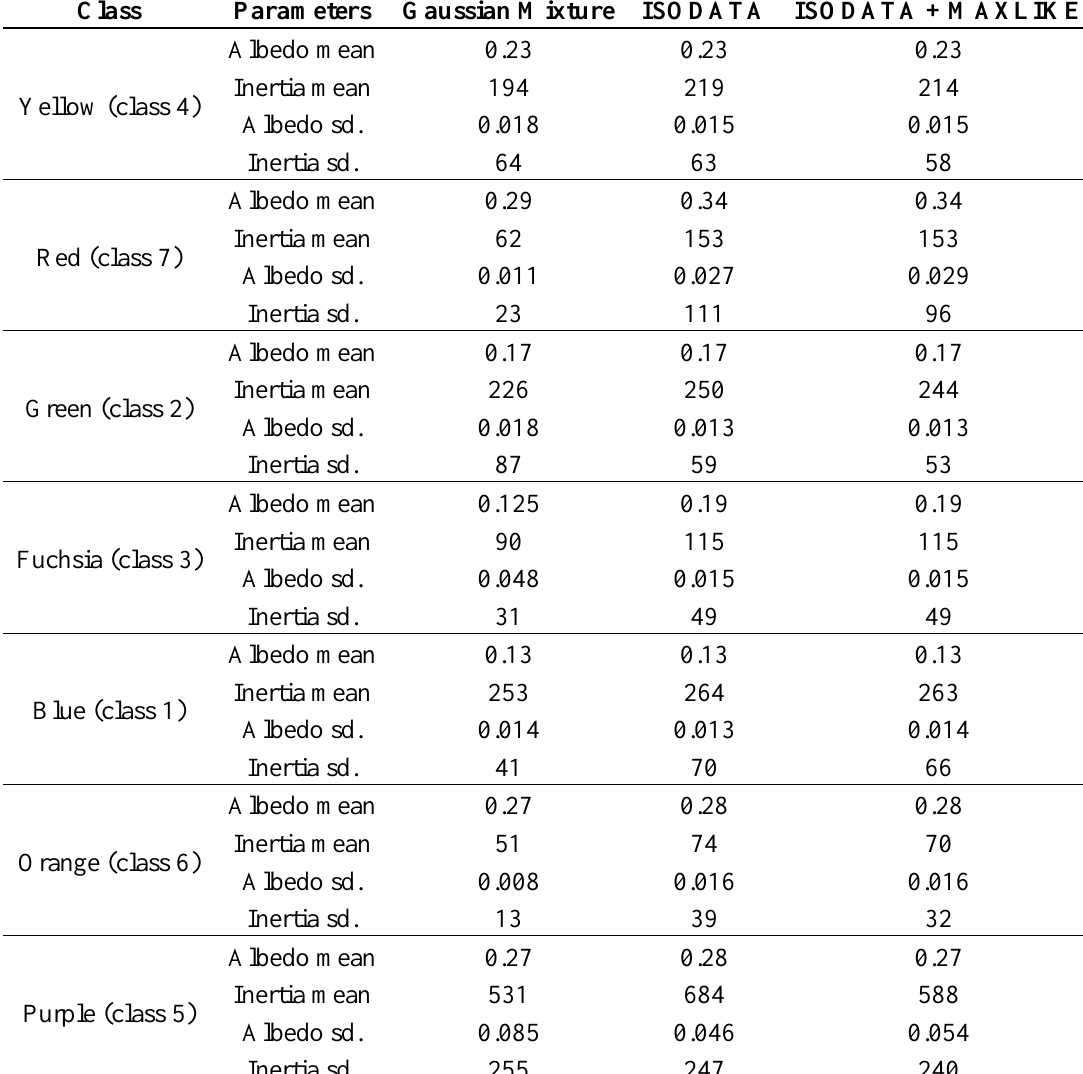
Table 5. Details of the seven classes produced by each